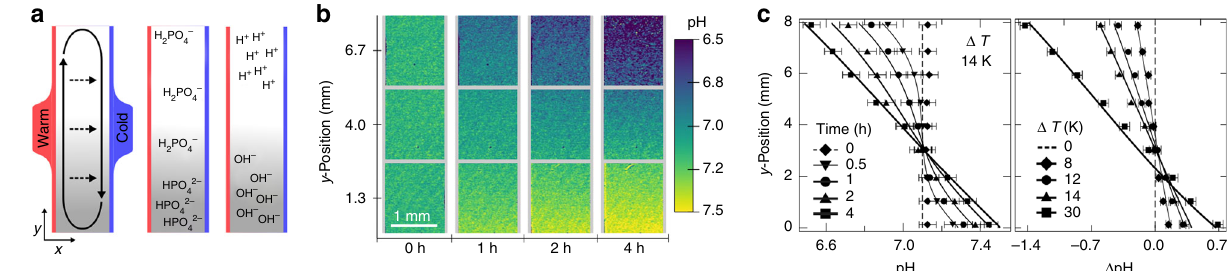
Fig. 2 Formation of pH gradients in phosphate solutions. a The temperature gradient creates a convective fl ow in the solution while simultaneously inducing a movement of molecules along the temperature gradient based on thermophoresis. The combination of both effects results in an accumulation of molecules at the bottom of the chamber. For the case of the phosphate buffer, HPO 4 2 − accumulates much stronger compared to H 2 PO 4 − . Based on the concentration of both buffer species, the pH is locally shifted. As a result, the pH increases at the lower regions and decreases at the upper regions of the chamber. b The formation of a pH gradient is monitored in a 8 mm high chamber via the ratiometric dye SNARF-1. c For a given temperature difference of Δ T = 14 K, a stable proton gradient of Δ pH = 0.93 develops within 4 h (see Supplementary Movie 1). The steepness of the proton gradient changes with respect to Δ T and is in good agreement with our theoretical model. Differences in pH are achieved after 4 h for a Δ T = 8, 12, 14 K and after 1 h for a Δ T = 30 K. The error bars give the standard deviation of the SNARF-1 detection for equation